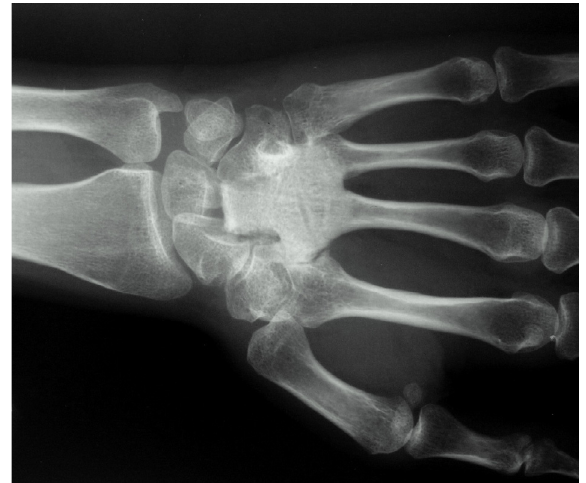
Figure 4. Roentgenogram of the operated wrist at 6-month